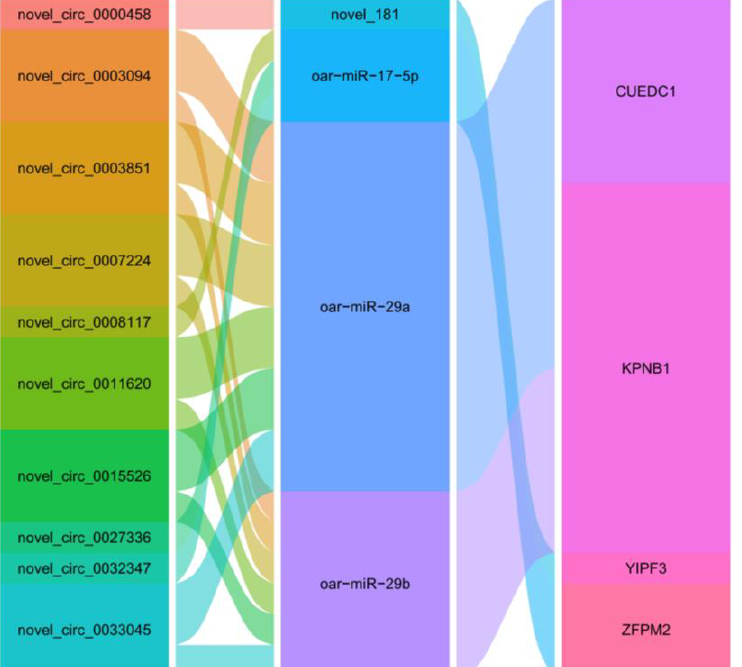
Figure 6. Co-expression network of DEcircRNA-DEDEmiRNA-mRNA. The left column represents DEcircRNA, the middle column represents DEmiRNA, the right represents DEmRNA, and the edges represent the relationship between them. The larger edge widths indicate the number of pathway connections.